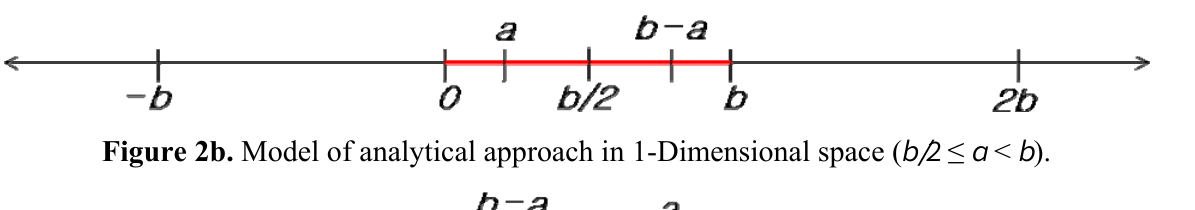
Figure 2a. Model of analytical approach in 1-Dimensional space ( 0 ≤ a < b/2 ).